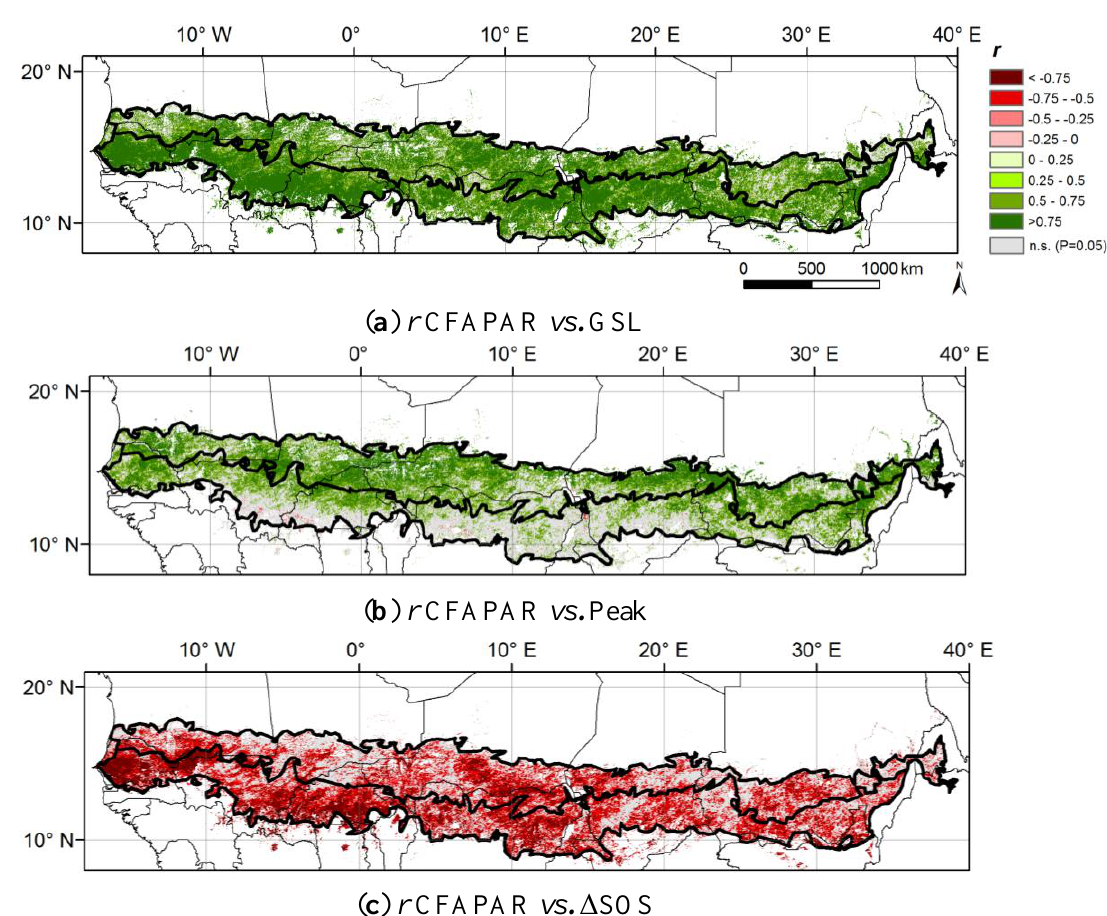
Figure 4. Correlation coefficient between CFAPAR and GSL ( a ); Peak ( b ); ΔSOS ( c ). Land cover polygons (thick black lines) are as in Figure 3. Pixels where the linear regression is not significant (n.s.) at p = 0.05 are masked in